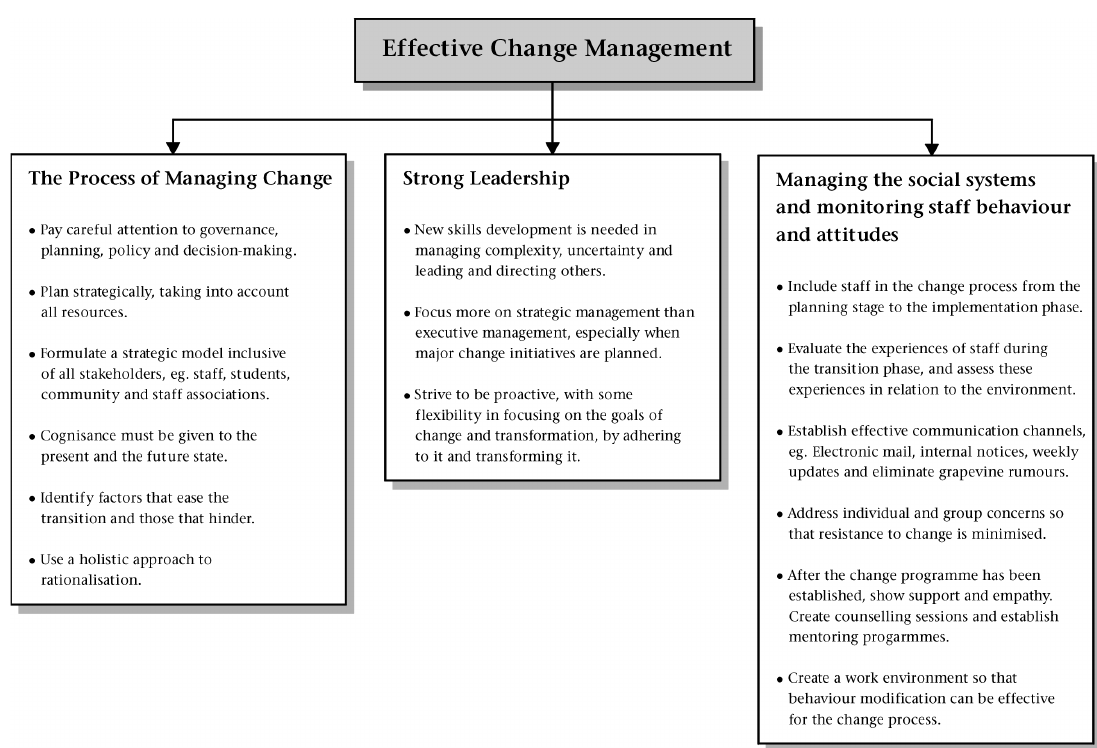
Figure 4: Critical recommendations – managing the change process and the need for strong